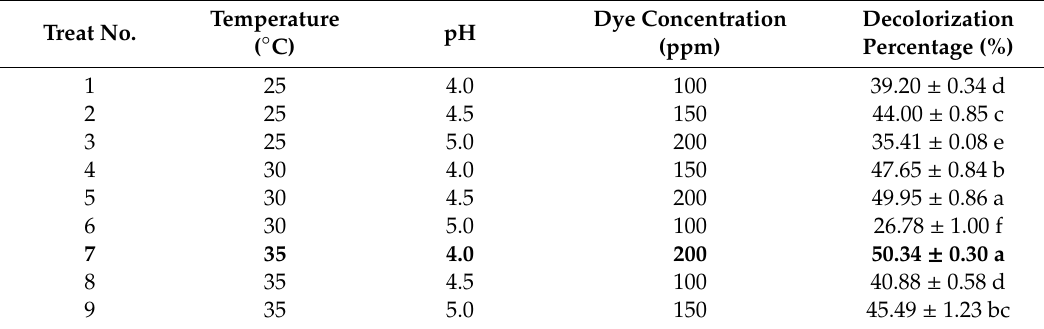
Table 1. Decolorization of RBBR Determined by Three-factor and Three-level